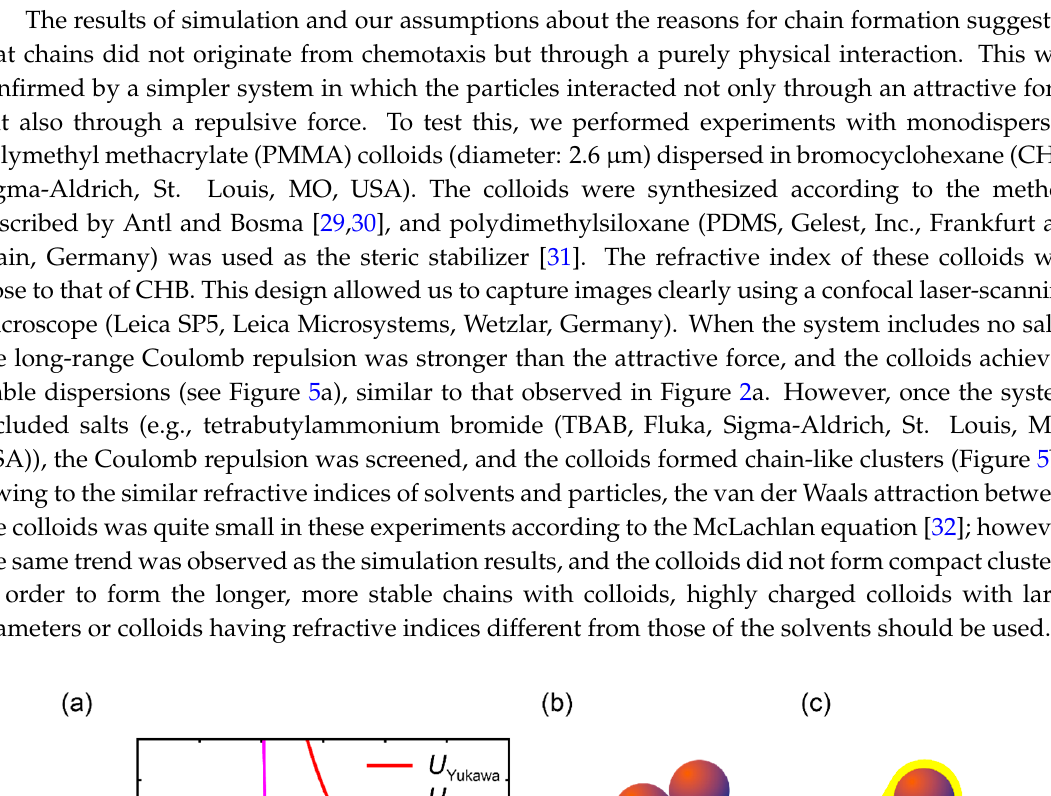
Figure 5. Observation of charged colloids. Charged colloids are used as a model system, and are observed using confocal microscope. ( a ) Colloids are dispersed in the medium without salt. Colloids do not form chain-like clusters, and this phase corresponds to Figure 2a; ( b ) Chain-like structure in a simple system. The colloidal dispersion, including salts, which screened the interactions of charged colloids (diameter: 2.6 μ m), also exhibited the same configuration as cells, indicating that this structure formed without the assumptions of interactions and chemical reactants. Scale bars show 25 μ m.